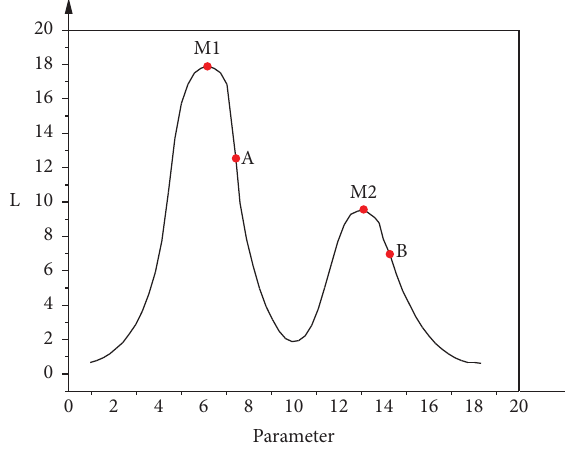
Figure 3: Local optimal problem.